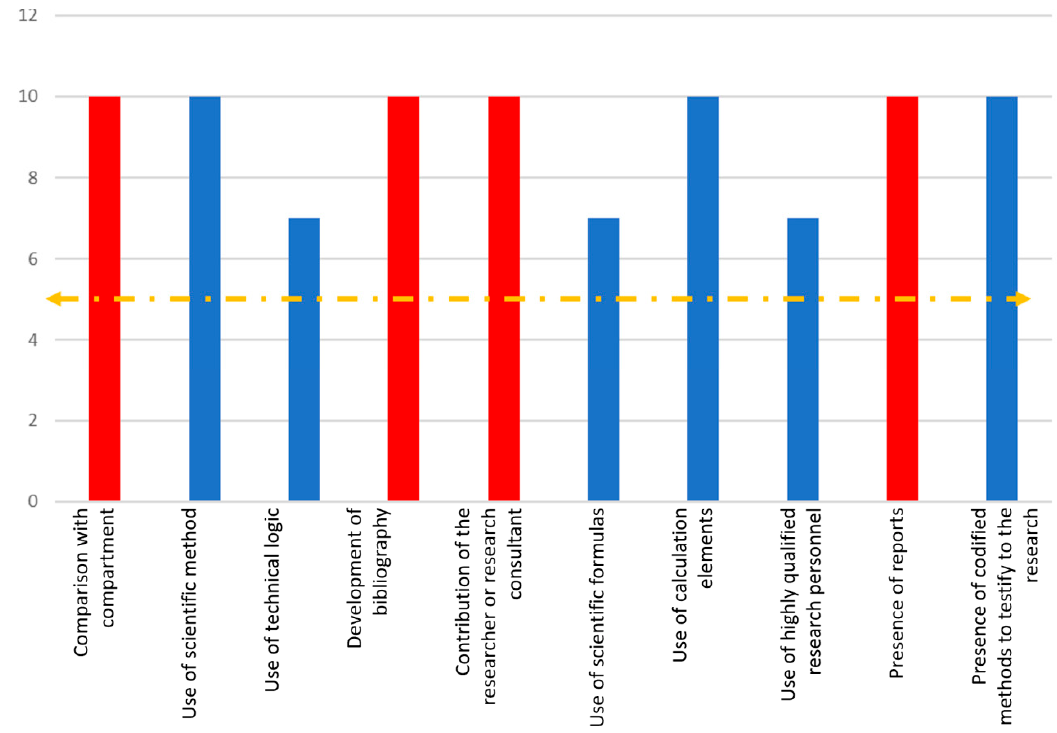
Figure 7. The basic parameters considered to be systematic are in red, the minimum required level of the parameters is represented by the orange line, and the accessory parameters of systematicity is in blue.